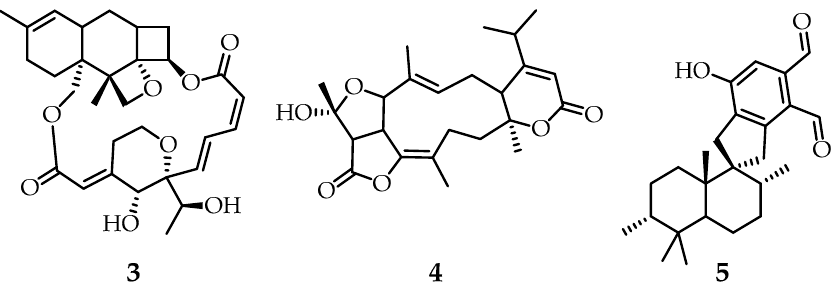
Figure 2. Structure of stachybotrichromens 3 – 5 .